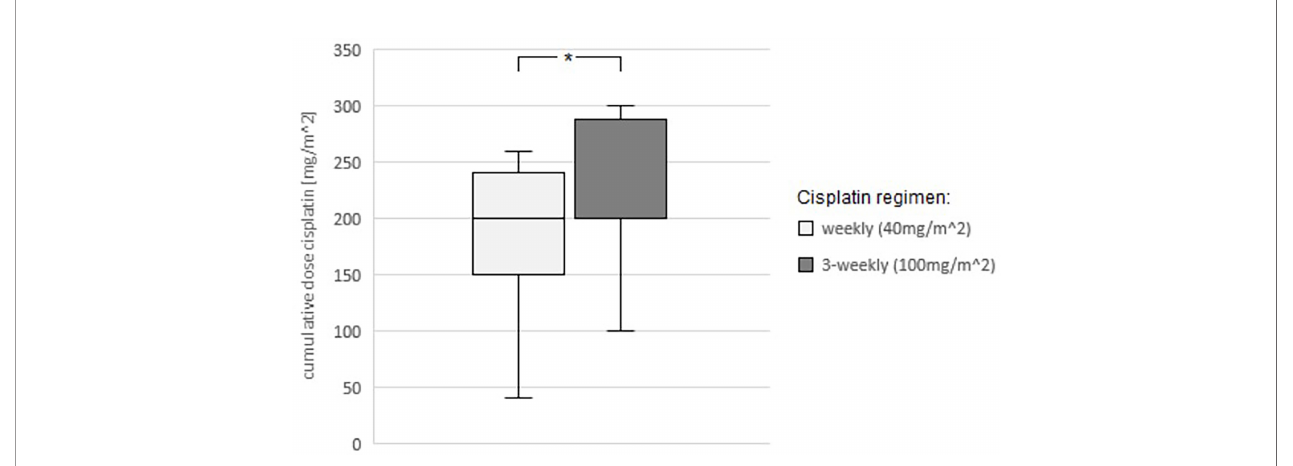
FIGURE 7 | Comparison of the average cumulative total dose of cisplatin achieved between the two regimens (weekly administration 40mg/m^2 body surface area and 3-weekly administration 100mg/m^2 body surface area). Student ’ s t-test: p=0.046, statistically signi fi cant (*) mean CDC(weekly)= 183.33mg/m^2; mean